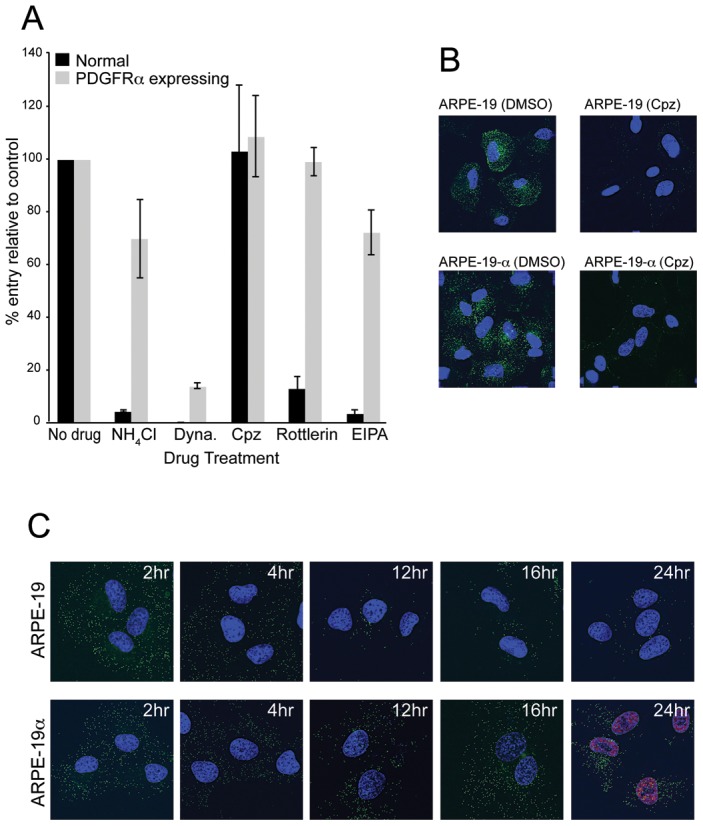
The pathway of HCMV entry into PDGFRα expressing epithelial cells is different from that involving normal ARPE-19 cells.
A) ARPE-19 cells were transduced with Ad-tet-trans alone (Normal) or Ad-PDGFRα and Ad-tet-trans (PDGFRα expressing) for 24 hr at 37°C. The cells were incubated with 0.2% DMSO (No drug), 50 mM ammonium chloride (NH4Cl), 150 µM dynasore (Dyna), 30 µM chlorpromazine (Cpz), 30 µM Rottlerin, or 75 µM EIPA for 1 hr at 37°C then HCMV TR (10 IU/cell) was added for an additional 4 hr in the presence of drugs. The cells were then washed to remove the virus inoculum then incubated in media containing 10% FBS and the same concentration of drug for 24 hr at 37°C. The relative level of HCMV infection was measured by comparing the number of IE-86 positive cells in drug-treated cells with cells treated with 0.2% DMSO. The bars represent the averages from three separate wells from one experiment with standard deviations shown. Other experiments produced very similar data. B) ARPE-19 or ARPE-19α cells were treated with either 0.2% DMSO or with 30 µM chlorpromazine (Cpz) for 1 h at 37°C then incubated with media containing Alexa-fluor-488 transferrin and DMSO or chlorpromazine for 30 min at 37°C. The cells were placed on ice, washed briefly with citrate buffer, pH 3.0 to remove cell surface transferrin, fixed, the nuclei stained with DAPI, then analyzed by fluorescent microscopy. C) ARPE-19 or ARPE-19α cells seeded on glass coverslips were incubated with UL32-EGFP-HCMV using 10 IU/cell for 1 hr at 37°C then the cells washed and incubated for an additional 2, 4, 12, 16 hr in growth media before the cells were fixed, nuclei counterstained with DAPI, and cells analyzed by fluorescence microscopy. Cells incubated for 24 hr were fixed, permeabilized, and stained for the HCMV IE-86 early antigen along with an Alexa-fluor-594 secondary antibody and then counterstained with DAPI. Coverslips were mounted on glass slides and a 0.2 µm section of the Z-stack (including the central plane of the nucleus) was captured.